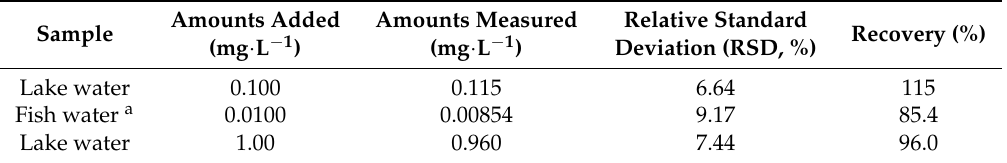
Table 1. Analytical results of spiked samples ( n =